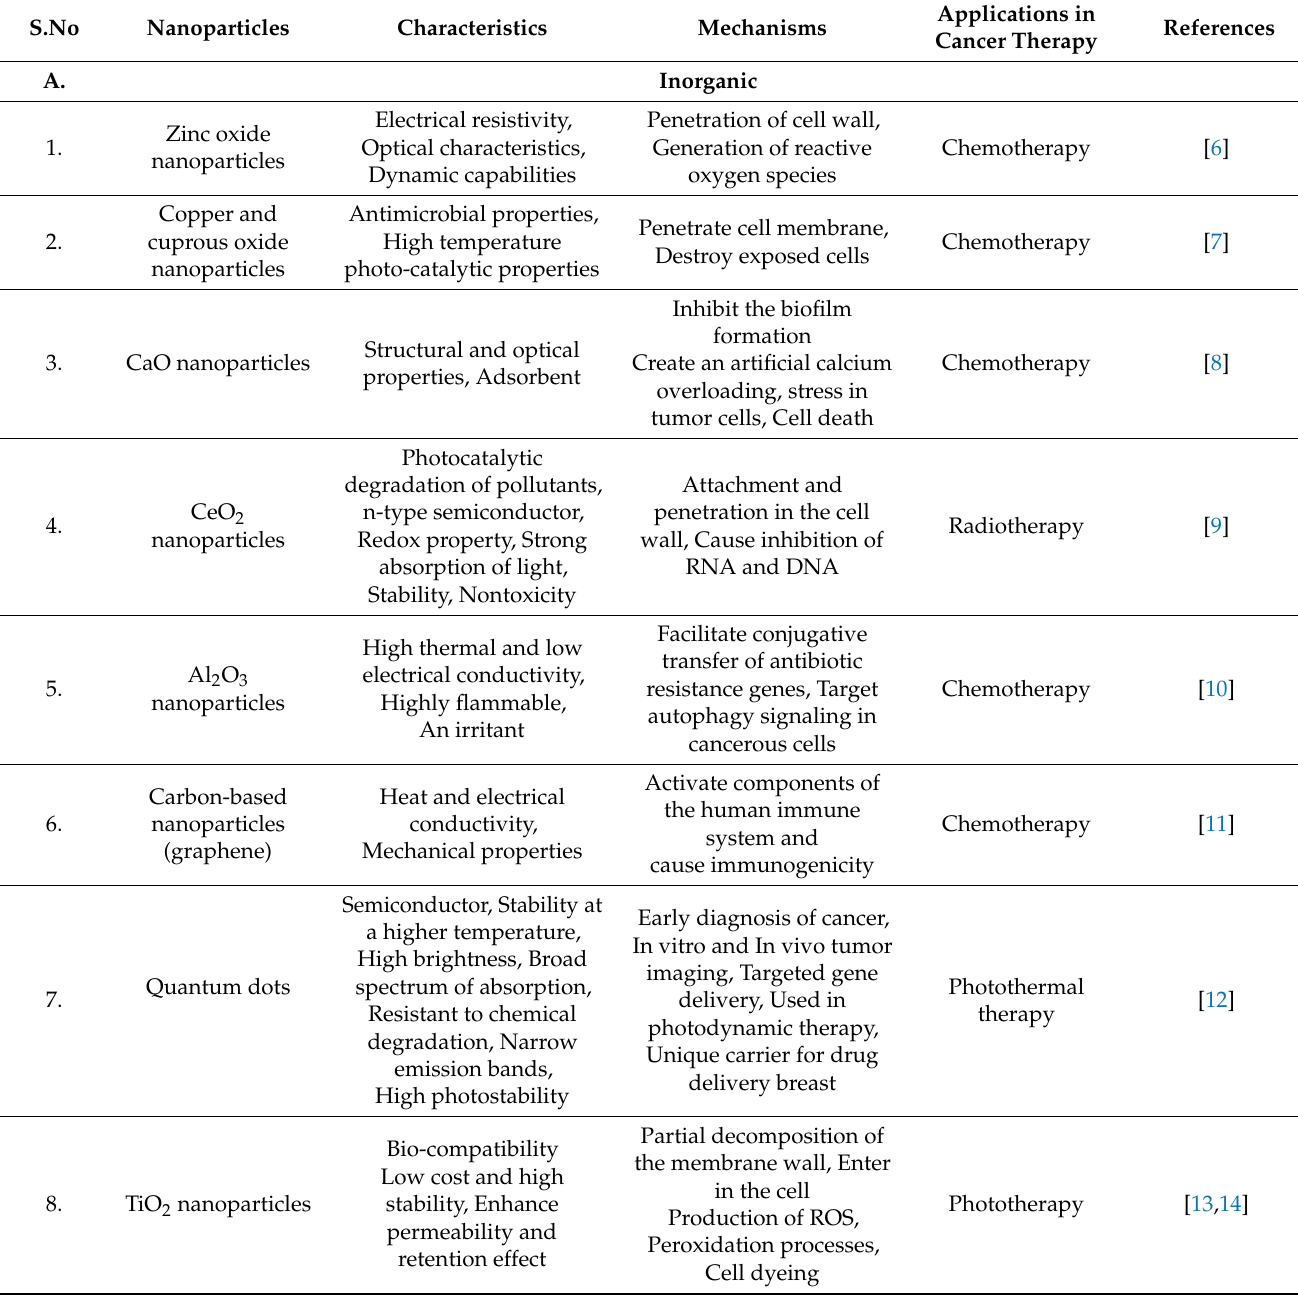
Table 1. A different class of nanoparticles, their characteristics, mechanism of function, and applica- tion in cancer